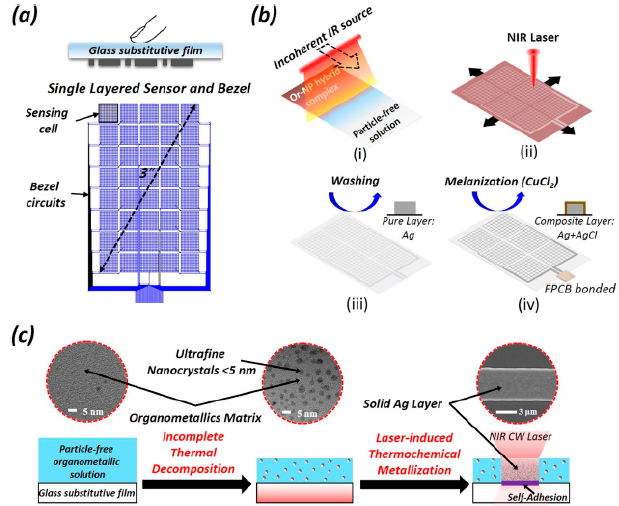
Figure 14. The ( a ) cross-sectional view and ( b ) schematic diagram of the fabrication steps of the developed touch device. The different steps included the (i) in situ generation, (ii) laser-processing (iii) rinsing and (iv) melanization processes. ( c ) Schematics of laser induced microfabrication using thermochemical direct metallization done on enhanced organometallic/ nanoparticle hybrid complex during the laser-induction process to form particle-free organometallic solution. The inset shows the transmission electron microscopic image of the hybrid complex and scanning electron microscopic (SEM) image of the laser-processed layer on the left and right, respectively [109].